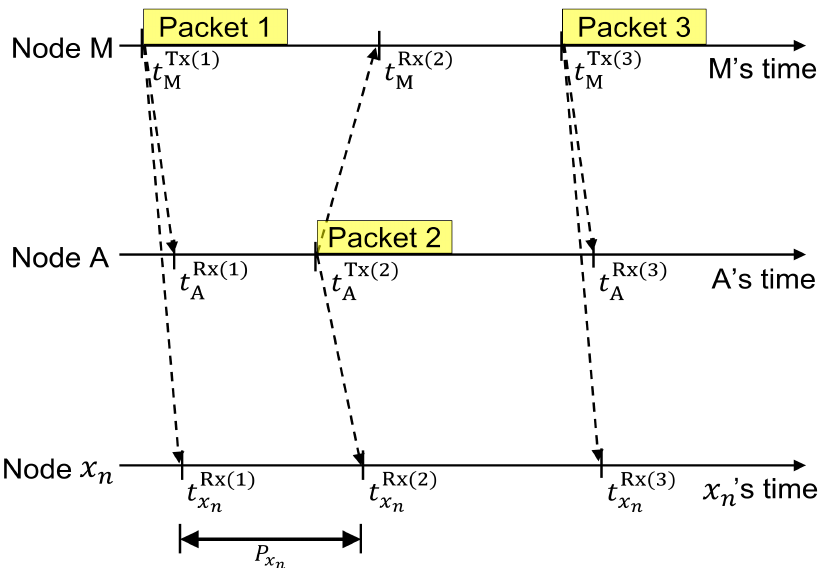
Figure 1. Schematic diagram of a TWR session. Mobile node M transmits the first and third sensing packets, active anchor node A transmits the second sensing packet, and all passive anchor nodes x n from X = { x 1 , x 2 , . . . , x N } , ∀ n ∈ { 1, . . . , N } listen to the three sensing packets. t Tx respectively denotes the transmission and reception timestamp values of the k -th packet reported by node i , and P i denotes the reception time difference of node i